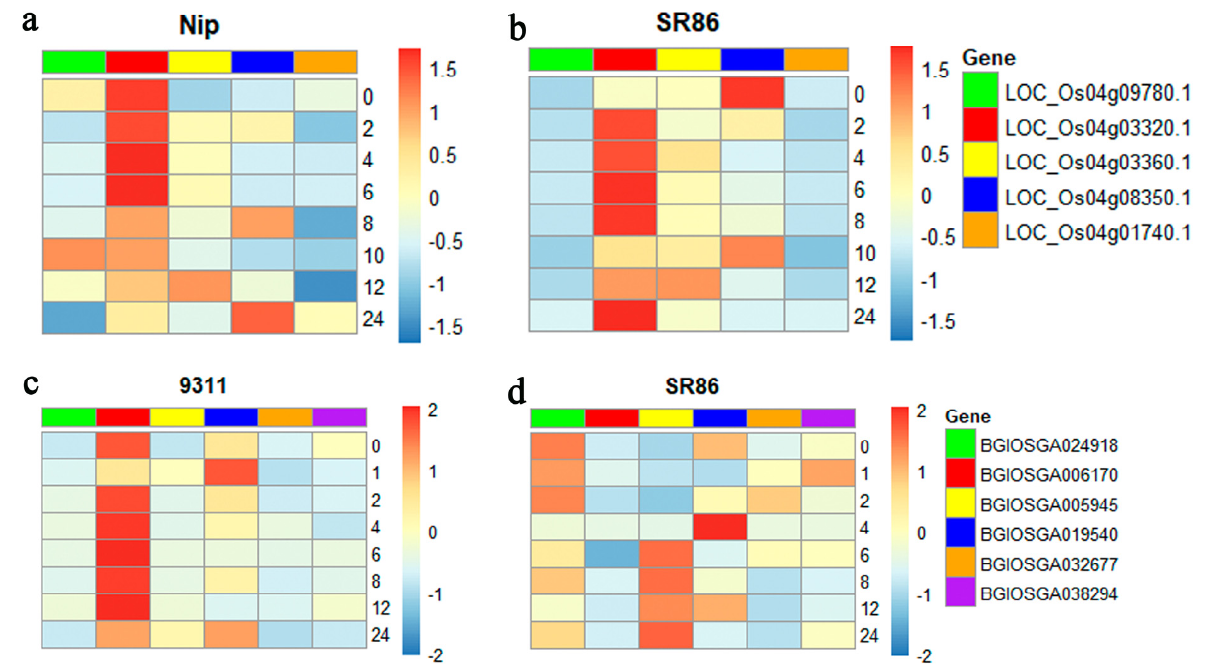
Figure 7. The expression validation of candidate genes in SR86, Nip, and 9311 plants under normal (0 mM NaCl) and salt stress (150 mM NaCl) conditions by RT − qPCR. ( a ) Expression of candidate genes in Nip. ( b ) Expression of candidate genes in SR86. ( c ) Expression of candidate genes in 9311. ( d ) Expression of candidate genes in SR86. Plants were treated with 150 mM NaCl for 24 h. The abscissa indicates the salt concentration and the ordinate shows the relative gene expression level, which was calculated using the 2 − ∆∆ CT method. Data represent the mean ± SD of three biological